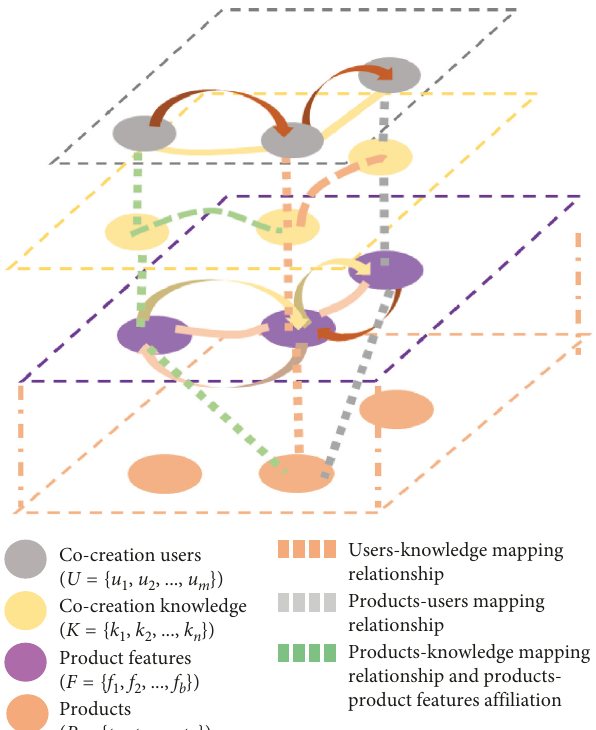
Figure 1: Co-creation knowledge network cyberspace for product